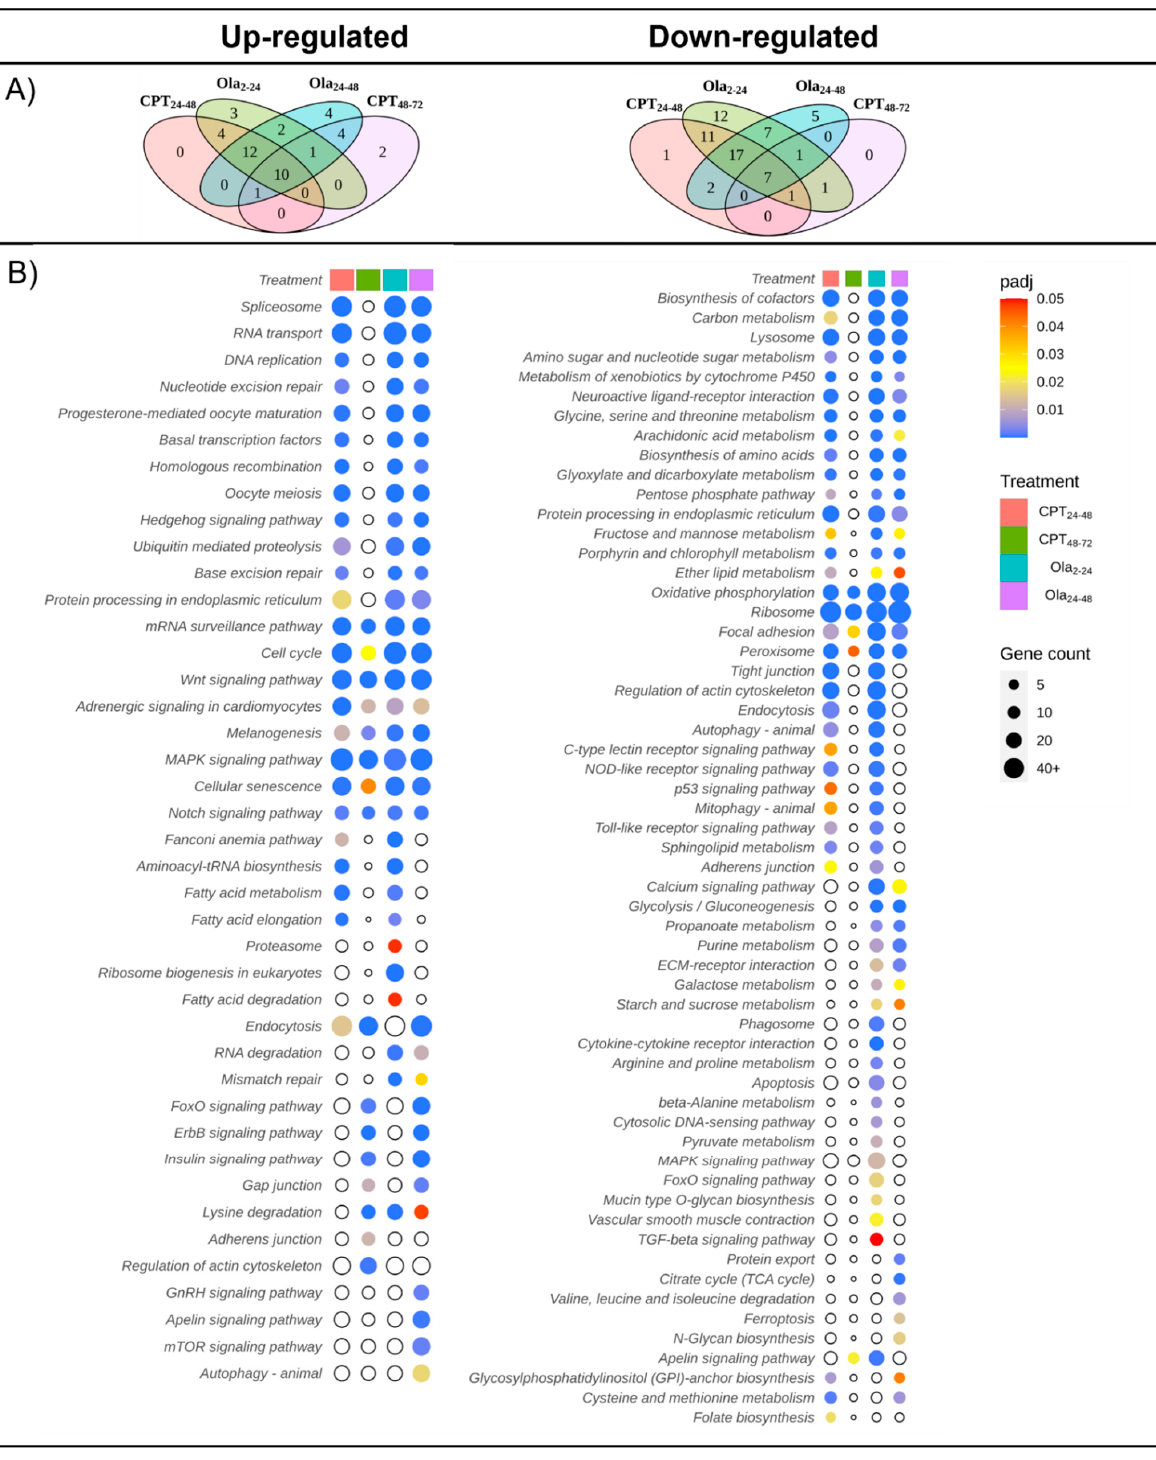
Figure 5. Enriched KEGG pathways in the treated versus the control embryos of sterlet ( A. ruthenus ). ( A ) Overlap in the enriched KEGG pathways between treatments; ( B ) visualization of the level of significance and number of representative DEGs found in each pathway for each treatment group. The color scale represents adjusted p -values less than 0.05, with empty circles showing those greater than 0.05. The size of the circle represents the number of significantly differentially expressed genes that are part of the given KEGG pathway.